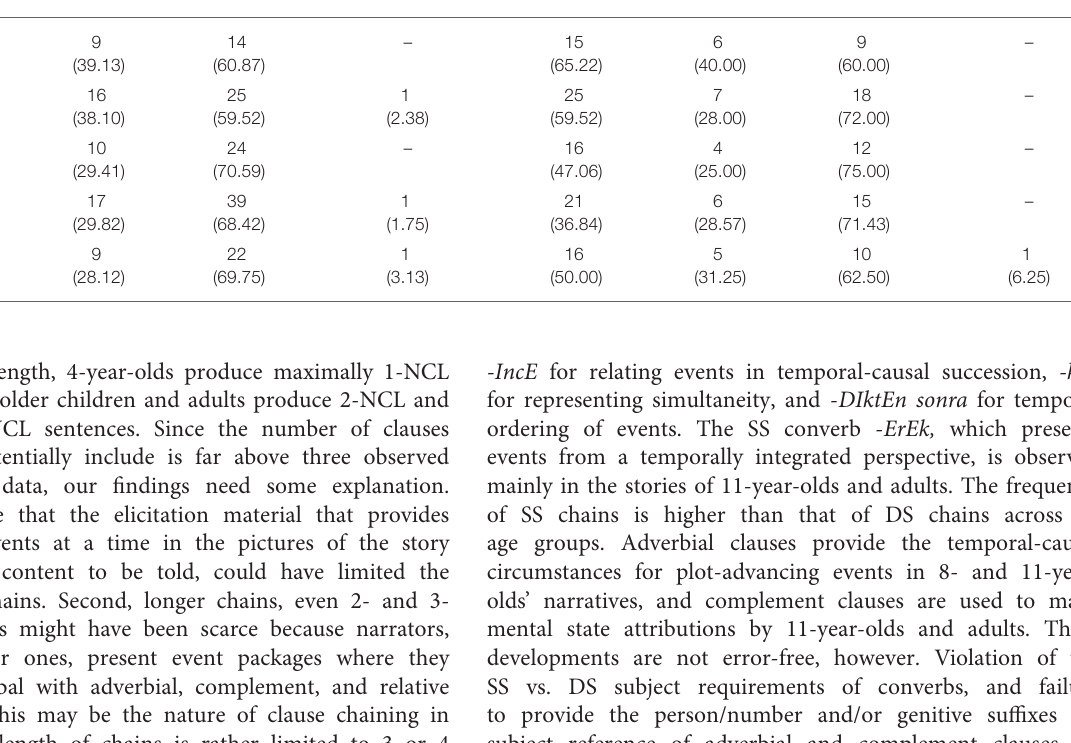
TABLE 9 | Frequency (and percentage) of DS, SS and 2SS-1DS combinations in 1-, 2- and 3-NCL chains and cross-sentence-boundary referential continuity (XSR) by age. Age Total DS chains SS